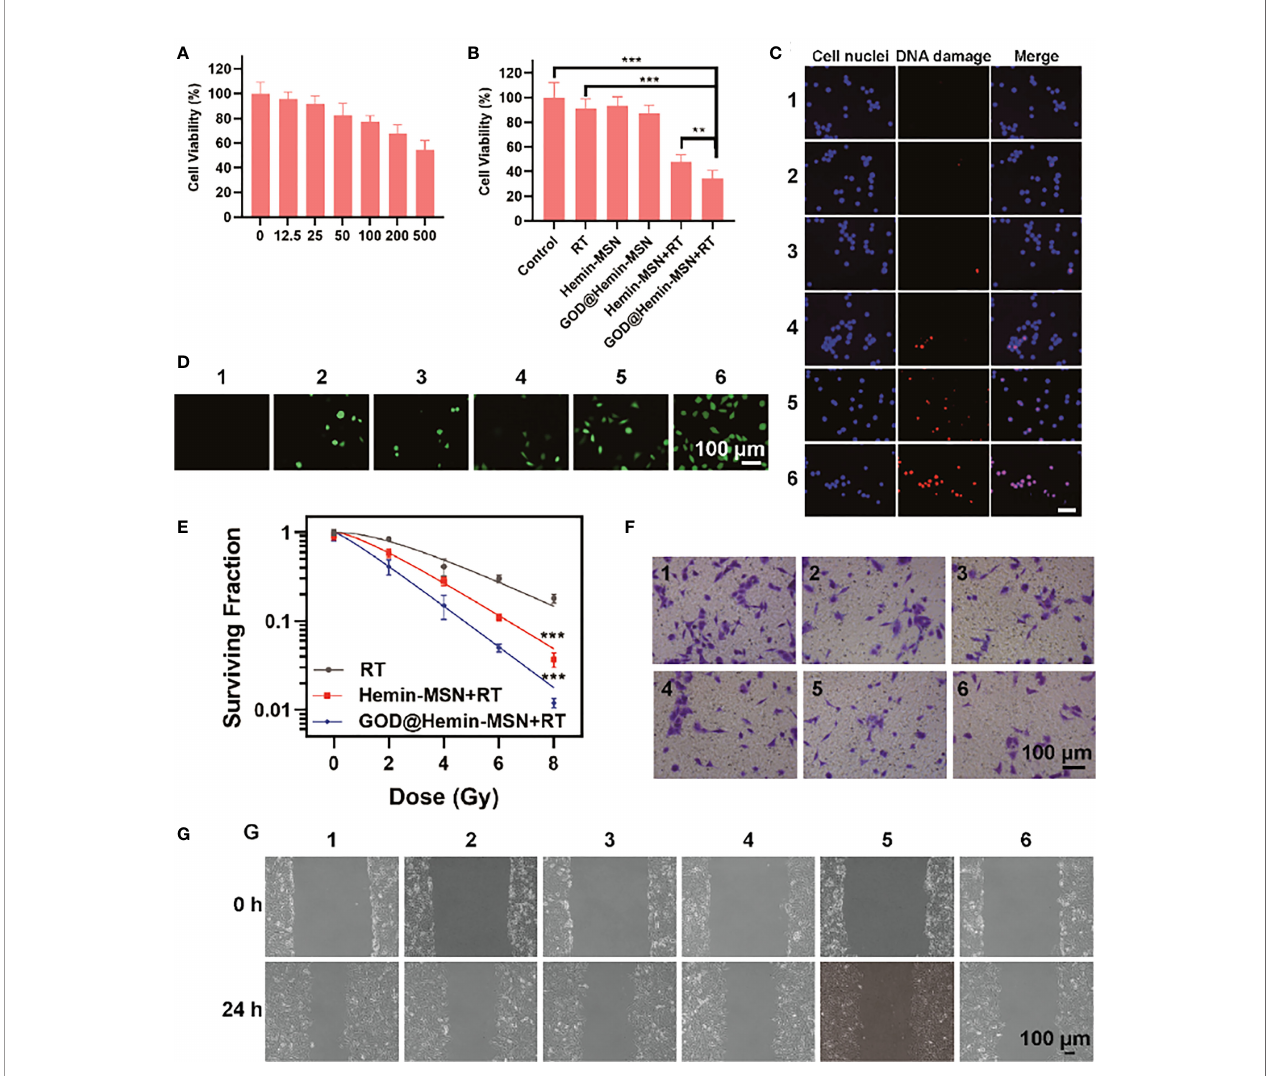
FIGURE 2 | Cell experiments. (A) Cell viability of normal human lung fi broblast (NHLF) cells after incubation with mesoporous silica decorated with hemin and glucose oxidase (GOD@Hemin-MSN) at various concentrations. (B) Cell viability of A549 cells after various treatments. (C) Confocal laser scanning microscopy (CLSM) images of g -H 2 AX staining. (D) CLSM images of reactive oxygen species (ROS) staining. (E) Colony formation. (F) Transwell experiments after various treatments. (G) Wounding assay. 1 , control; 2 , radiotherapy (RT); 3 , hemin-MSN; 4 , GOD@Hemin-MSN; 5 , hemin-MSN+RT; and 6 , GOD@Hemin-MSN+RT. Data are presented as the mean ± SD using one-way ANOVA with Tukey ’ s multiple comparison tests. *** p < 0.001; ** p <